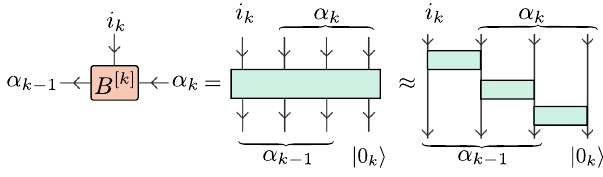
FIG. 9. An MPS tensor can be exactly represented as a unitary over some number of qubits, which can then be approximated as a series of two-qubit